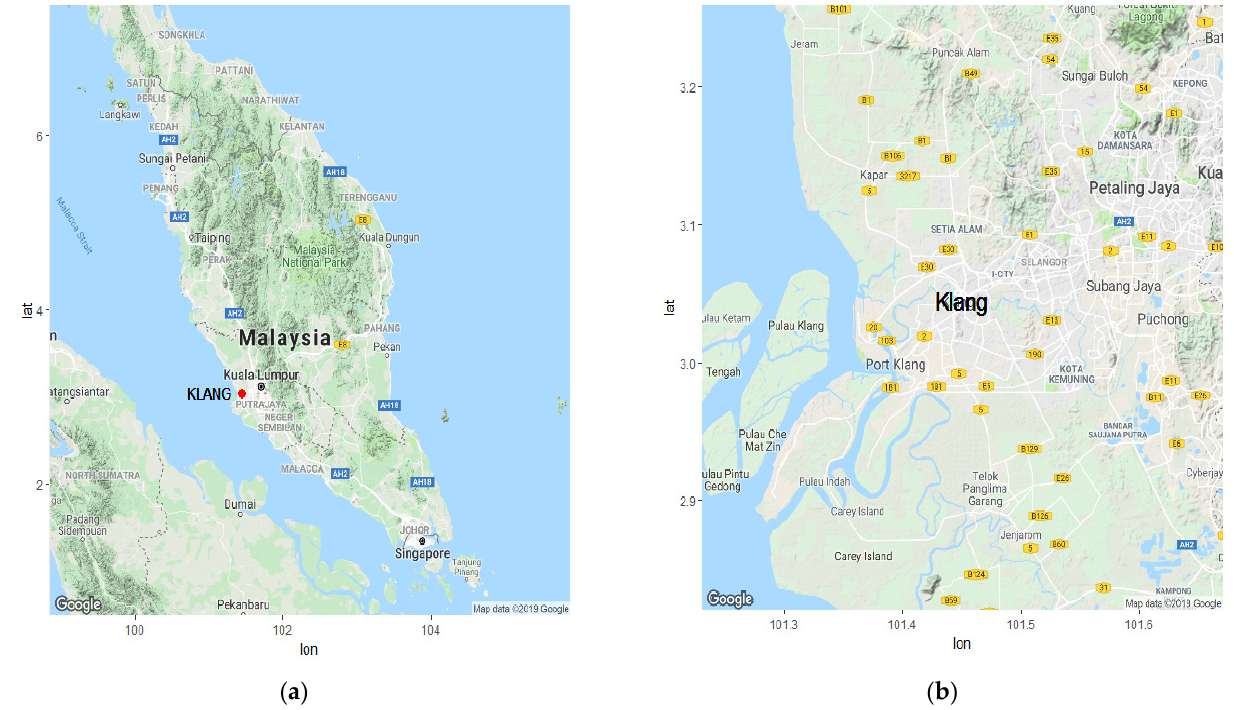
Figure 1. ( a ) Map of Peninsular Malaysia with Klang identified by a red dot, ( b ) Map of Klang [50].